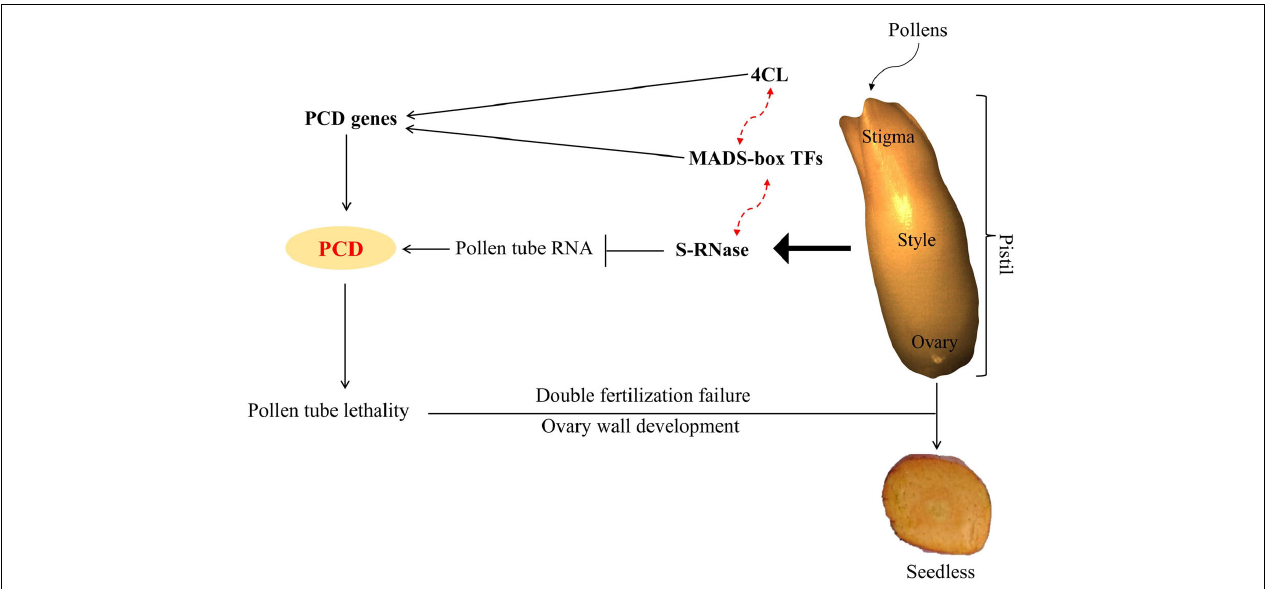
FIGURE 13 | Model depicting the possible mechanism for inducing seedless traits in oil palm. Solid lines indicate where the function of genes is known, while red dotted lines indicate the predicted function from our study.